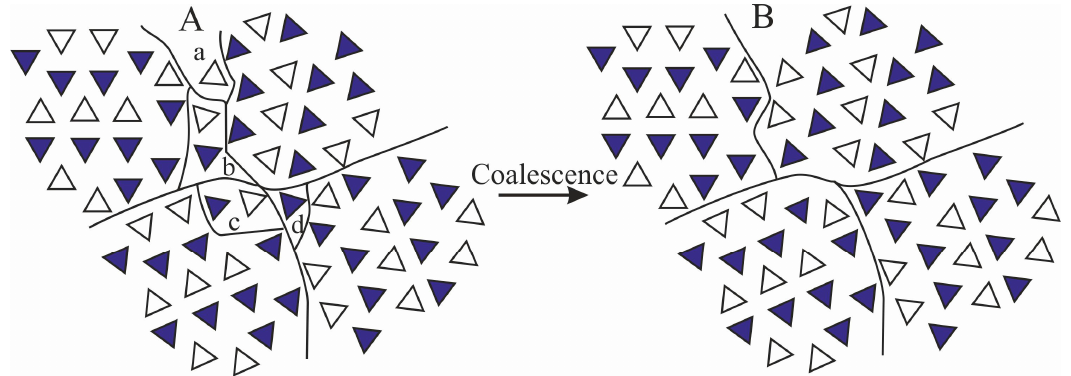
Figure 6. Model of coalescence of mesomorphic domains separated at the boundaries by isolated groups of 1–2 chains (sub-domains a–d) in a completely different arrangement ( A ) with formation of larger mesomorphic domains ( B ). By effect of stretching, the sub-domains a–d coalesce with close-neighbors mesomorphic domains.